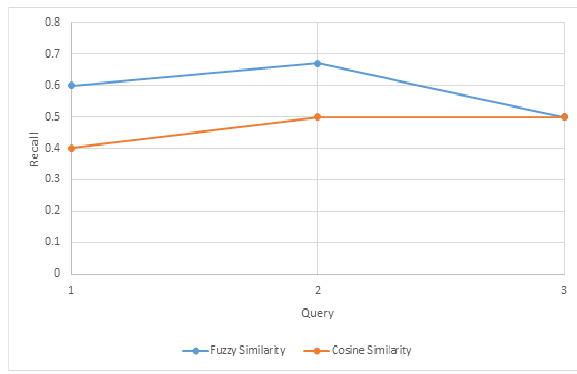
Figure 10 . Comparison of average Recall-Query